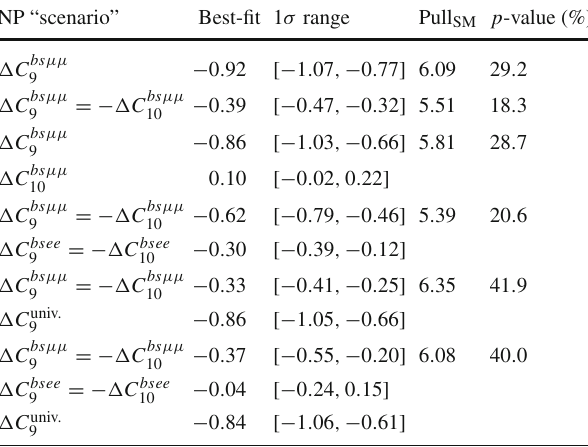
Table 2 Well-motivated NP “scenarios” and corresponding fits to the data on angular distributions, differential branching fractions and the LFUV ratios R K ( ∗ ) (as in Table 1), now including the recent LHCb measurements [25–30,186,187] (see Appendix B.1). The SM p -value is now found to be ∼ 1 .